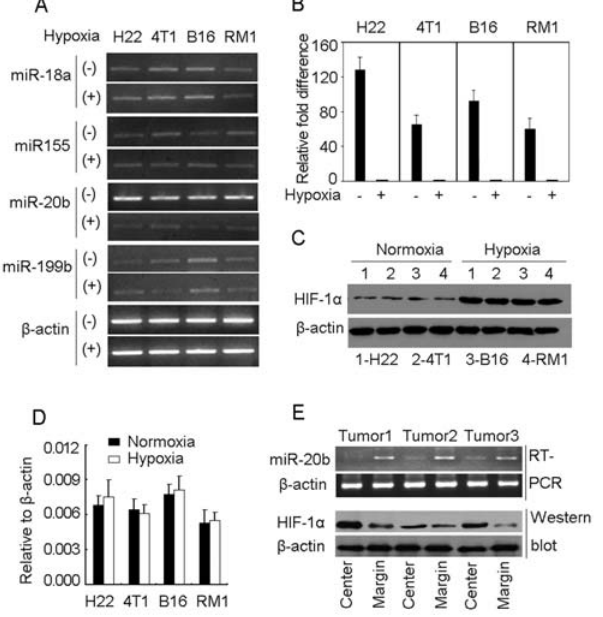
Figure 1. Expression of miR-20b is reversely correlated with HIF-1 a level in tumor cells. (A) The expressions of miR-18a, 155, 20b and 199b in tumor cell lines were detected by RT-PCR in normoxia (20% oxygen) or hypoxia (1% oxygen). (B) The detection of miR-20b in tumor cell lines by real time RT-PCR. The miR-20b level in the hypoxia groups was designated as 1. (C and D) The expression of HIF-1 a in tumor cell lines was detected by Western blot (C) or real time RT-PCR (D). (E) Expressions of miR-20b and HIF-1 a in different tumor regions. 1 6 10 5 H22 tumor cells were inoculated subcutaneously into mice. When tumor size was . 9 6 9 mm, the central and marginal regions of tumor tissues were used for miR-20b and HIF-1 a detection by RT-PCR and Western blot, respectively. Data from three tumor tissues were presented in this figure.